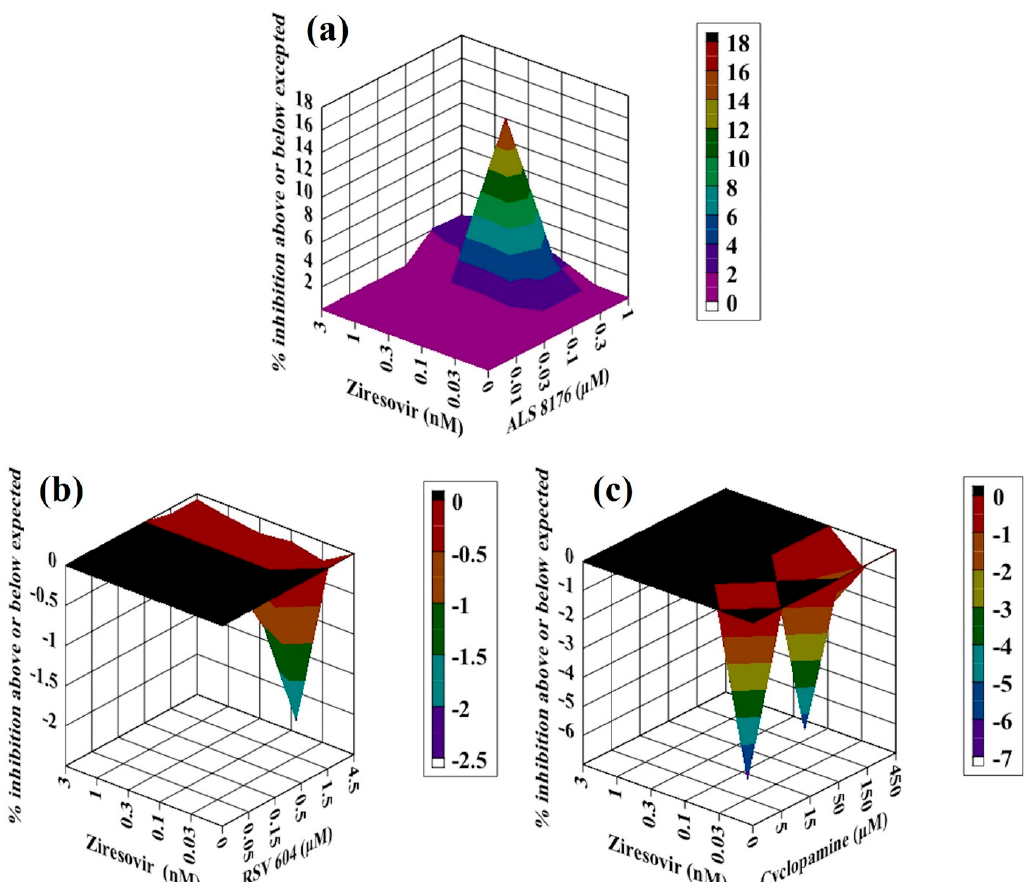
Figure 4. Analysis of compound interactions between RSV fusion inhibitor Ziresovir and RdRp inhibitors. HEp-2 cells infected with RSV–Luc were subjected to serial dilutions of Ziresovir (( a – c ); 0.03–3 nM), ALS8176 (( a ); 0.01–1 µ M),